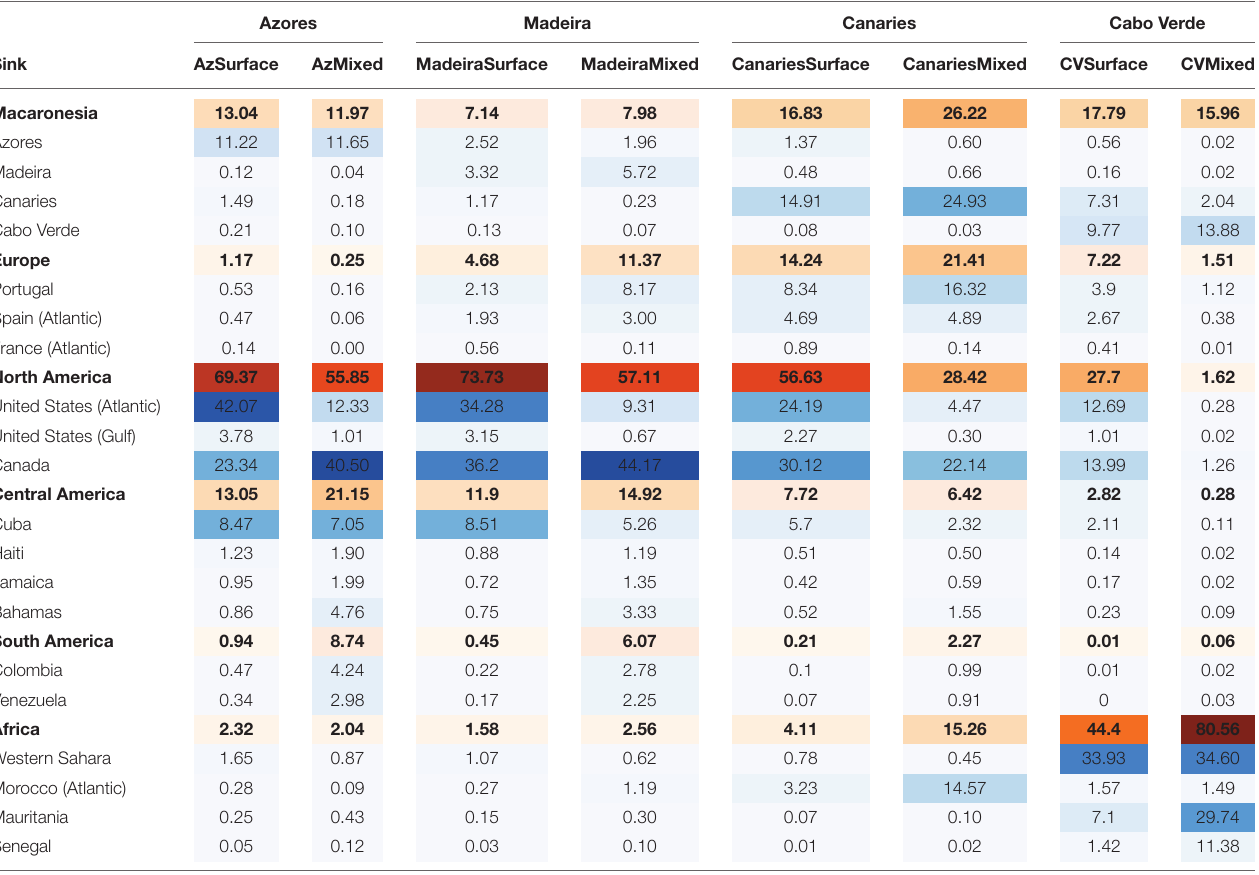
Values are expressed as the percentage of land-based particles, represented in Figure 8 and Supplementary Figure 7 . White-to-orange color scale is used for the cumulative proportion per continent, whereas white-to-blue color scale is used for the corresponding countries (only the most significant values are shown). Bold values are used to highlight the percentage of beached particles per